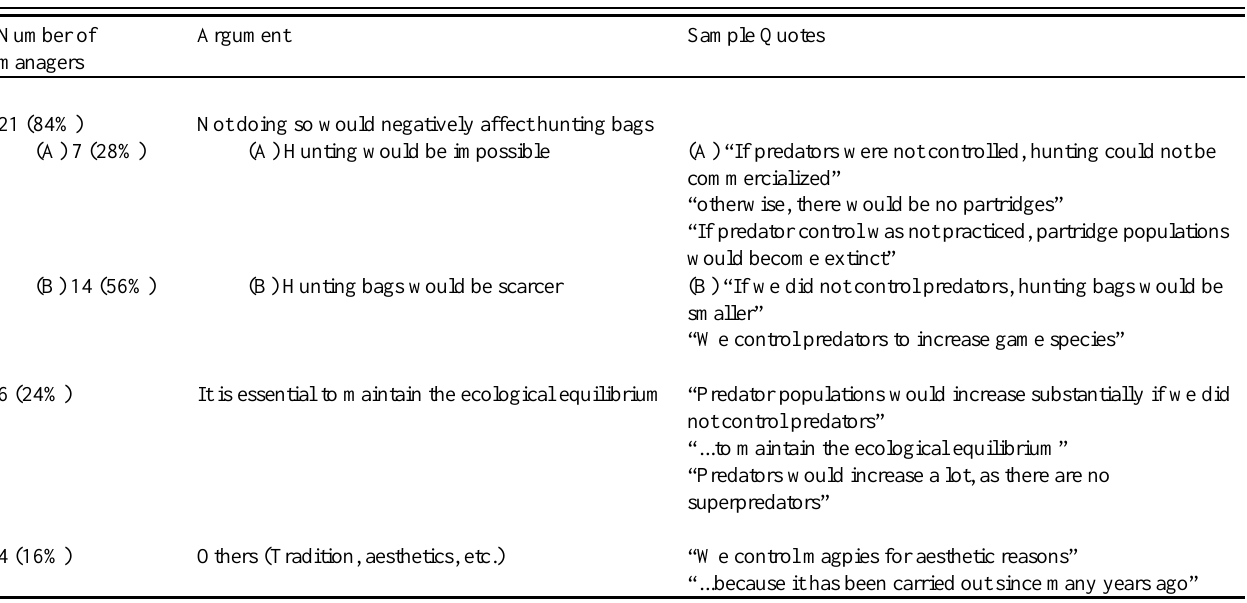
Table 3 . Main arguments given by managers for carrying out predator control; arguments revealed from 25 qualitative interviews. Note that some managers gave more than one